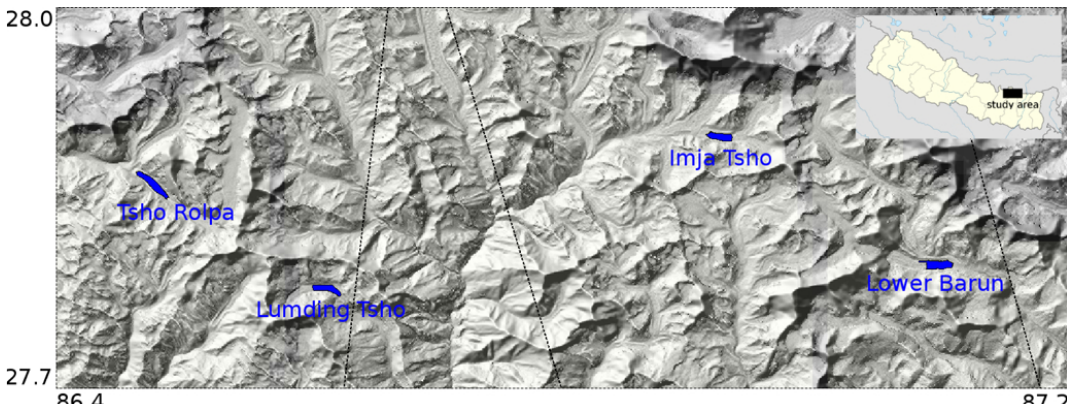
Fig. 3. Location map of the glacial lakes of interest in Nepal with footprints of the TerraSAR-X acquisitions (black frames). Image back- ground is a shaded relief of the SRTM DEM. The inset shows the location of the lakes in